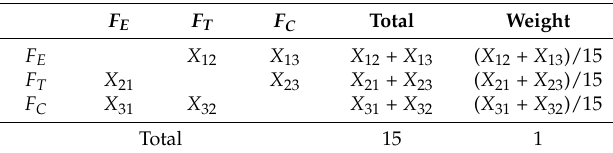
Table 1. Pecking-order comparison